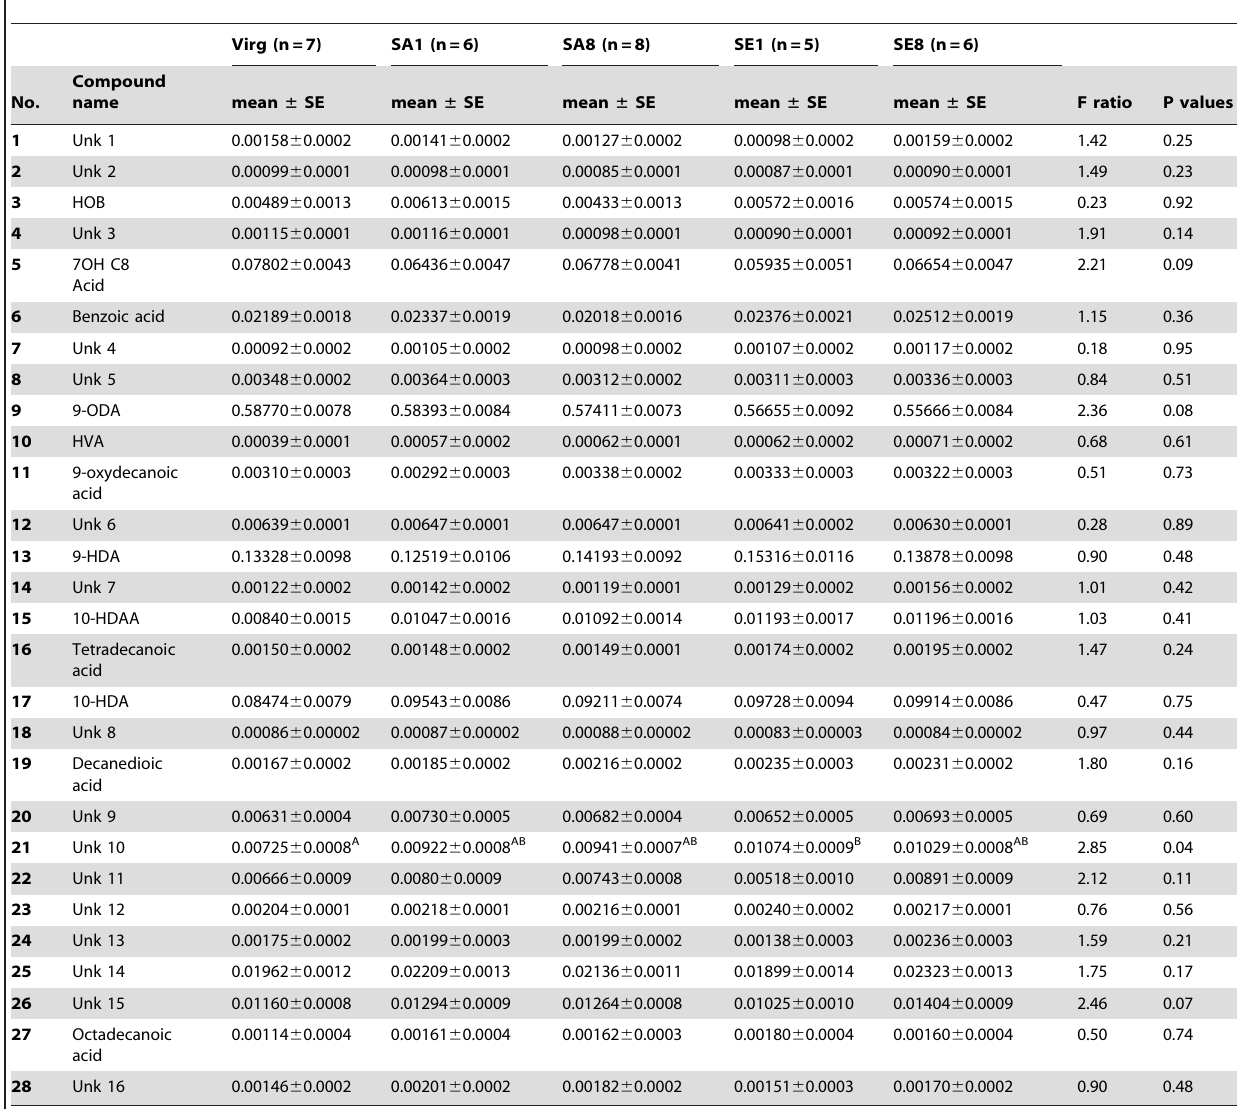
Table 2. Relative proportions of compounds found in mandibular glands of queens inseminated with different volumes and